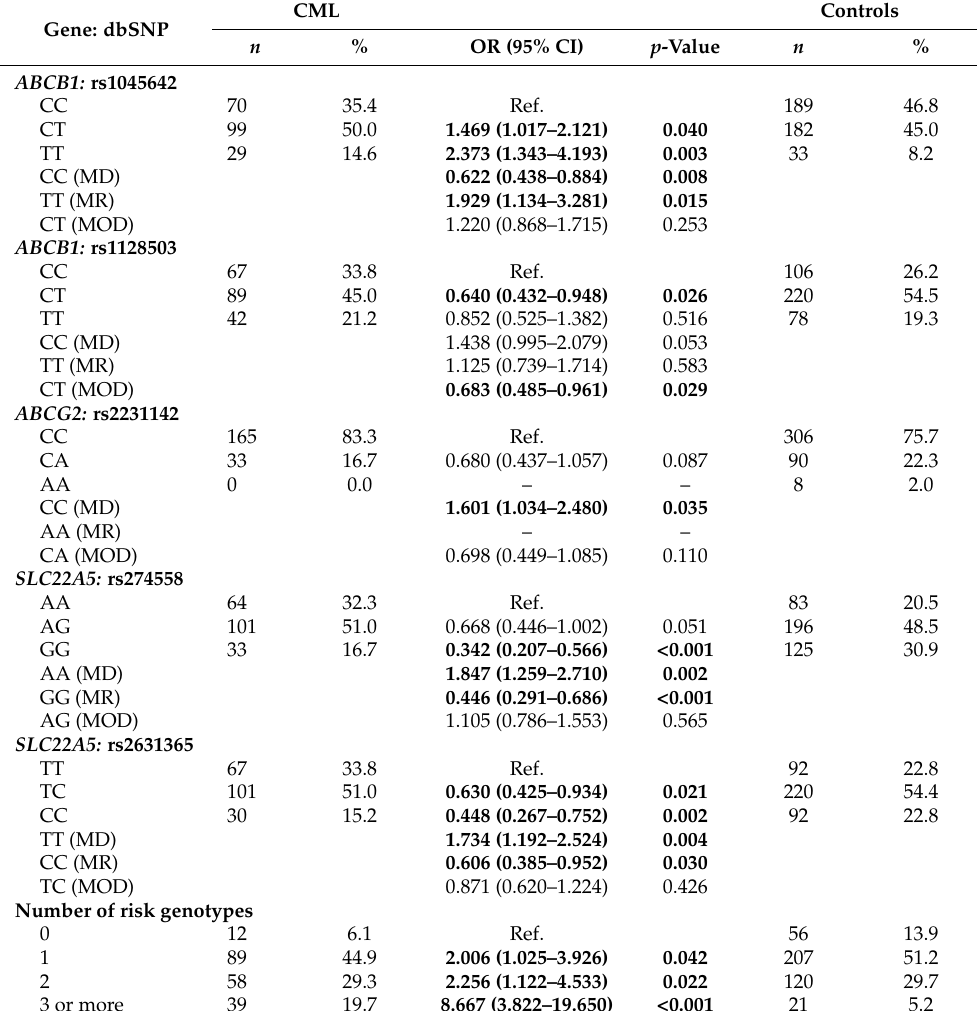
Table 3. Significant genotype distribution of selected SNVs in CML and controls, and its association with risk to